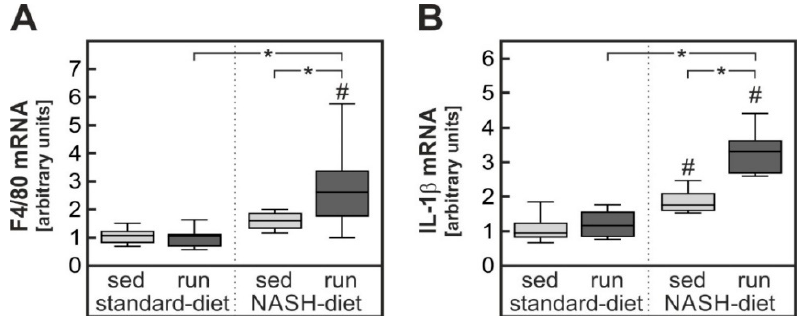
Figure 4. Enhanced inflammatory response in livers of NASH-diet fed trained rats. Rats were subjected to the different treatment groups described in the legend to Figure 1. The mRNA expression of F4/80 (gene name Adgre1, ( A )) and Interleukin-1 β (IL-1 β , ( B )) were quantified by RT-qPCR. Values are median (line), upper and lower quartile (box) and extremes (whiskers). Statistics: Two-way-ANOVA with Tukey’s post hoc test for multiple comparisons; #: significant versus sedentary standard-diet group, * p < 0.05 between compared groups.